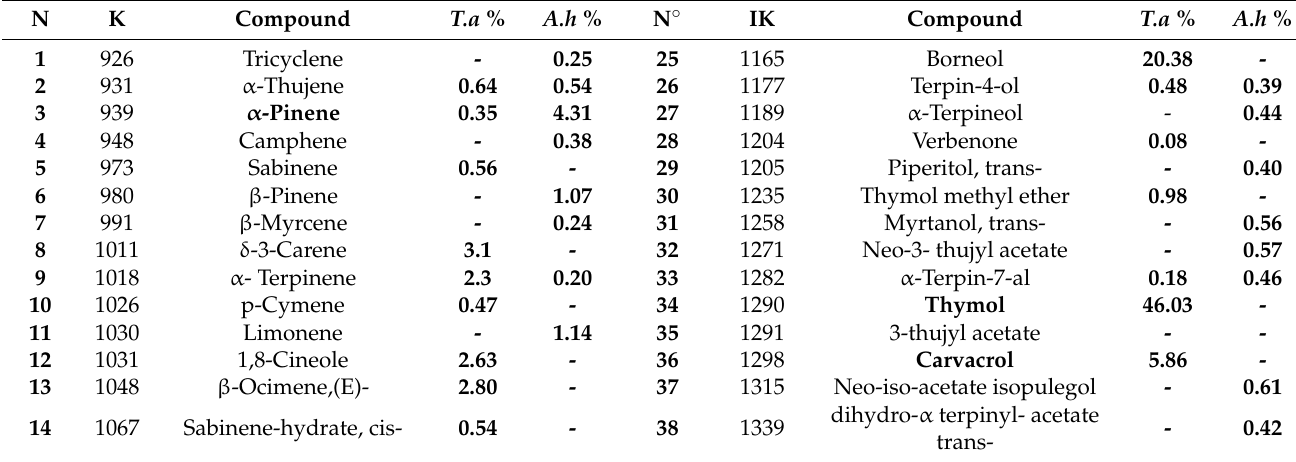
Table 1. Chemical compounds of A. herba-alba and T. algeriensis essentials